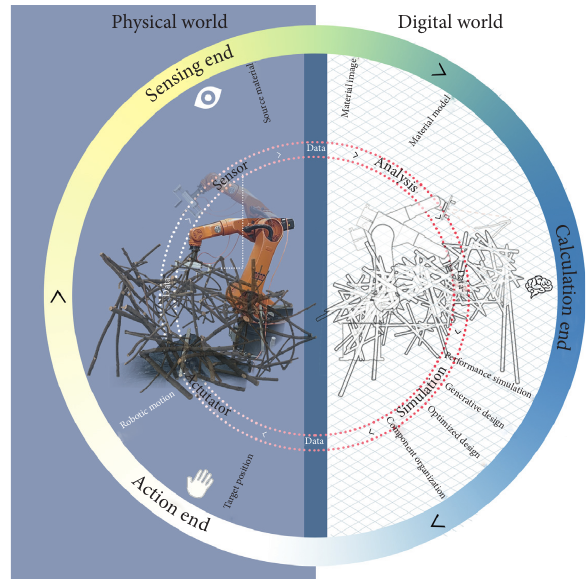
Figure 14: Cyber-physical construction.